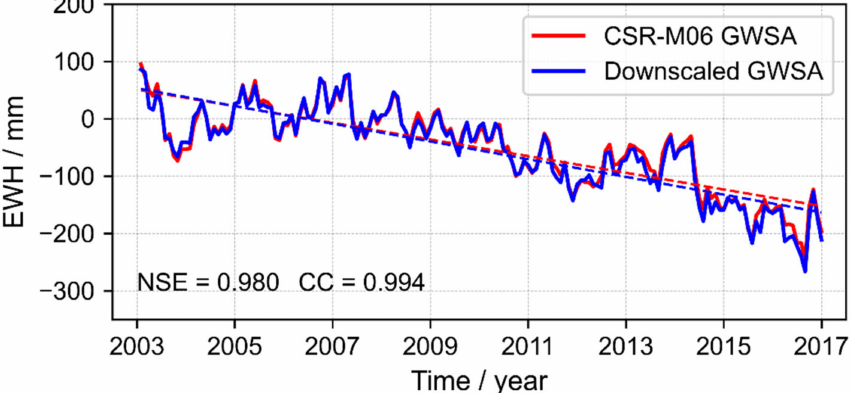
Figure 12. Time series of GWSA before and after downscaling in Guantao County. (Notice that the time series is the average signal of the small blue rectangle in Figure 11: 115.0 ◦ –115.5 ◦ E, 36.5 ◦ –36.75 ◦